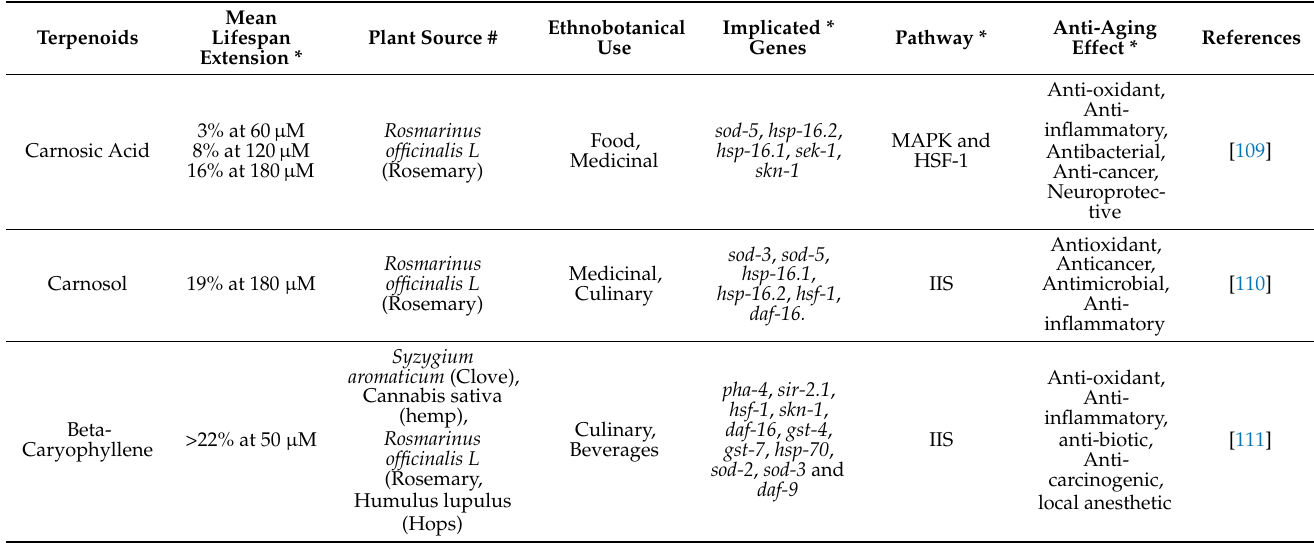
Table 2. Terpenoids with anti-aging and lifespan extending properties as demonstrated in the C. elegans model.